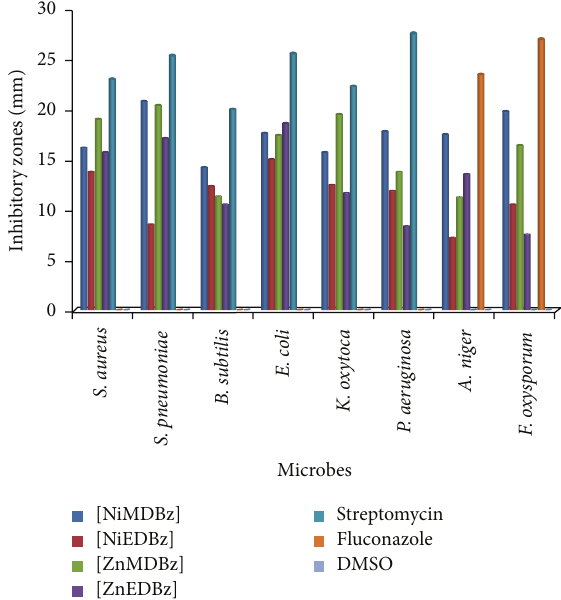
Figure 3: Histogram presentation of the antimicrobial properties of the mixed-ligand